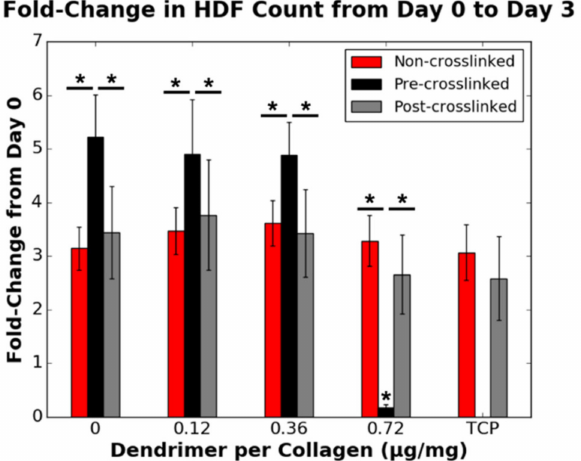
Figure 7. Effect of the quantity of IKVAV-capped dendrimers added to the various collagen substrates on the fold-change in HDF cell count from day 0 to day 3 ( n = 9). A fold-change of 1 is equivalent to no change in cell density. HDFs were seeded onto non-collagen coated wells (TCP controls) on the same 48-well plates as non-crosslinked and post-crosslinked films. * denotes statistically significant difference ( p ≤ 0.01) between the data point annotated and the respective 0 µ g/mg value for each collagen substrate, unless indicated otherwise.